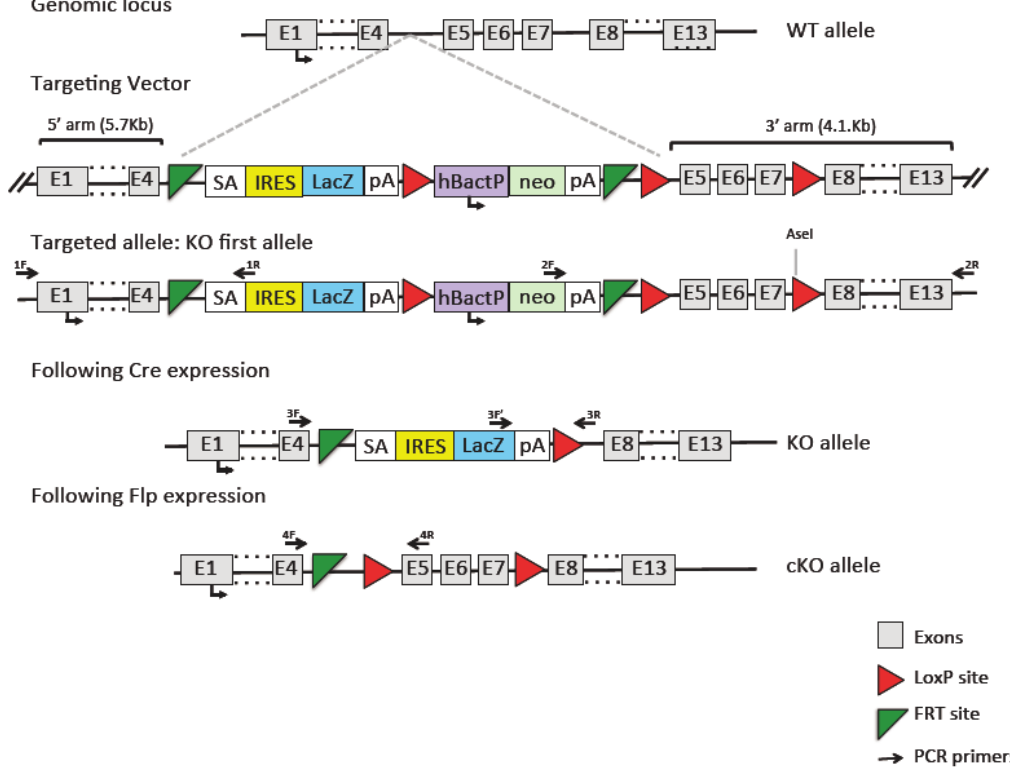
Figure 1. Sketch of the strategy for generation of a null Slc6a8 mouse. A targeting vector was obtained from KOMP to generate mice carrying a floxed allele. Crossing these mice with a Flp deleter mouse line produced a conditional KO mouse line (cKO allele). Crossing this line with a line expressing Cre-recombinase in the germline produced the Slc6a8 null mouse used in this study (KO allele). 1F, 1R, 2F, 2R, 3F, 3F’, 3R, 4F, 4R report the sites targeted by the PCR primers to assess allele